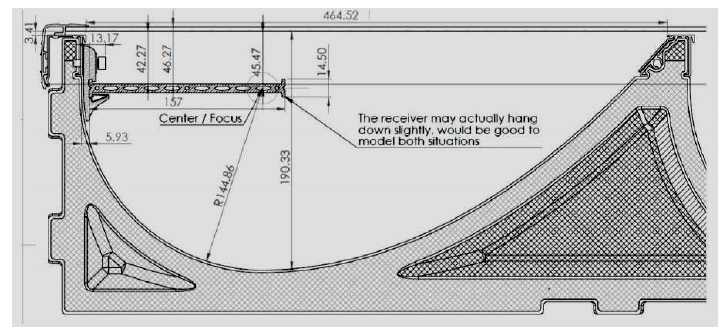
Figure 3. The detail of geometric concentration (all dominations in mm).